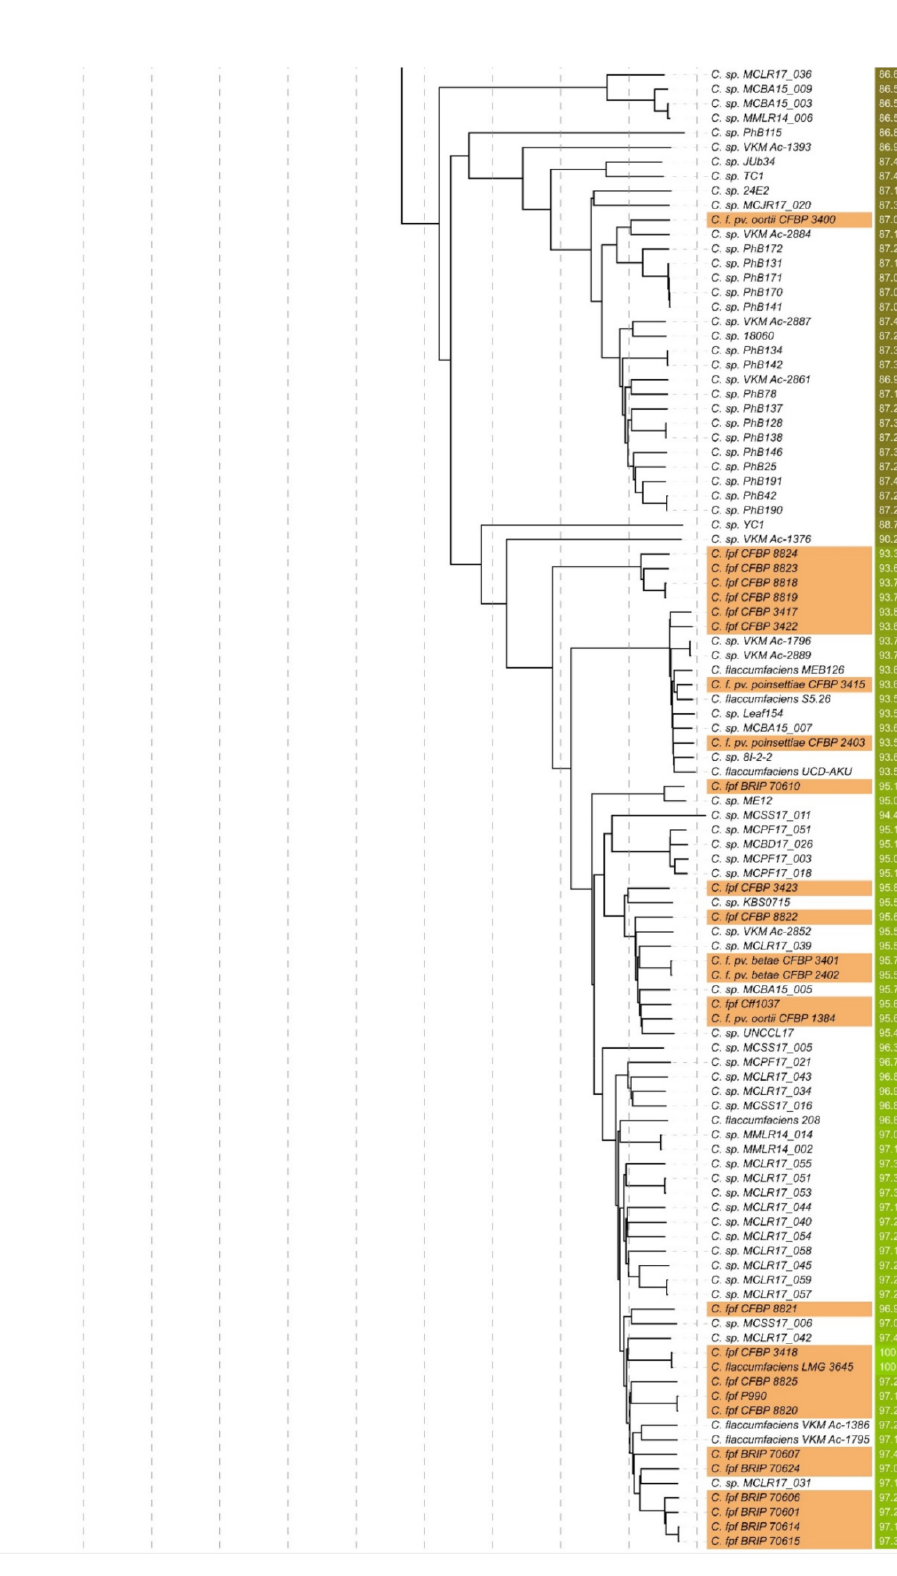
Figure 2. ANI tree plotted applying BioNJ clustering on 190 Curtobacterium genomes and Gryllotalpi- cola ginnsengisoli DSM 22003. The abbreviations are as follows: C .— Curtobacterium , G .— Gryllotalpicola , C. f. — Curtobacterium flaccumfaciens , and C. fpf — flaccumfaciens pv. flaccumfaciens . The C. fpf strains with confirmed pathogenicity are coloured yellow-orange. The scale bar shows 2% calculated ge- netic distance obtained by ANI calculations, and the trees were rooted to Gryllotalpicola ginnsengisoli DSM 22003. ANI values compared to the C. fpf CFBP 3418-type strain are shown to the right of the organism’s name and coloured according to a heat map